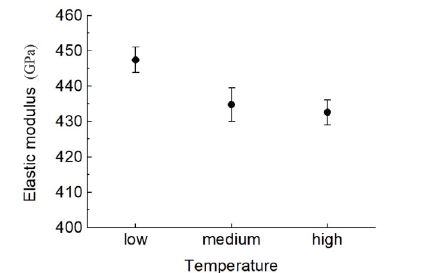
Fig. 10 Cross-sectional determined Young’s modulus for coatings deposited at different temperatures.